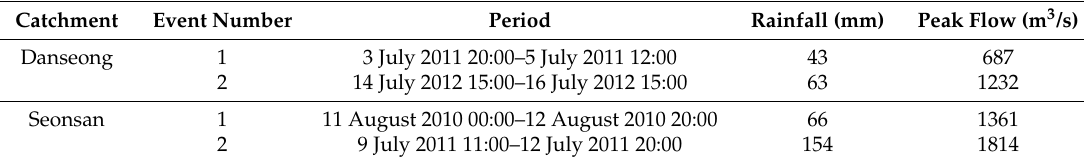
Table 3. Storm events for each